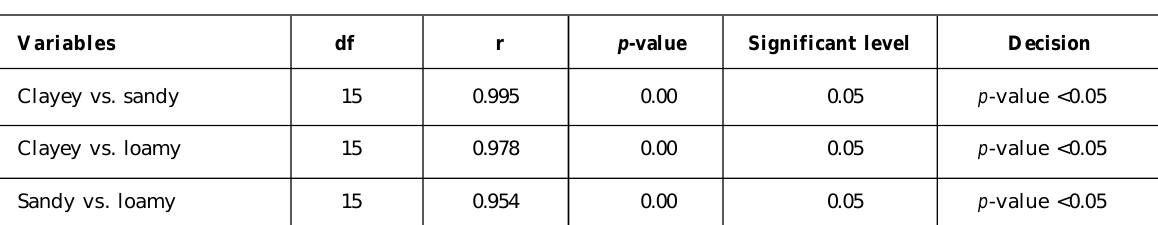
Table 4: Physic-chemical correlation analysis of contaminated soil textural class